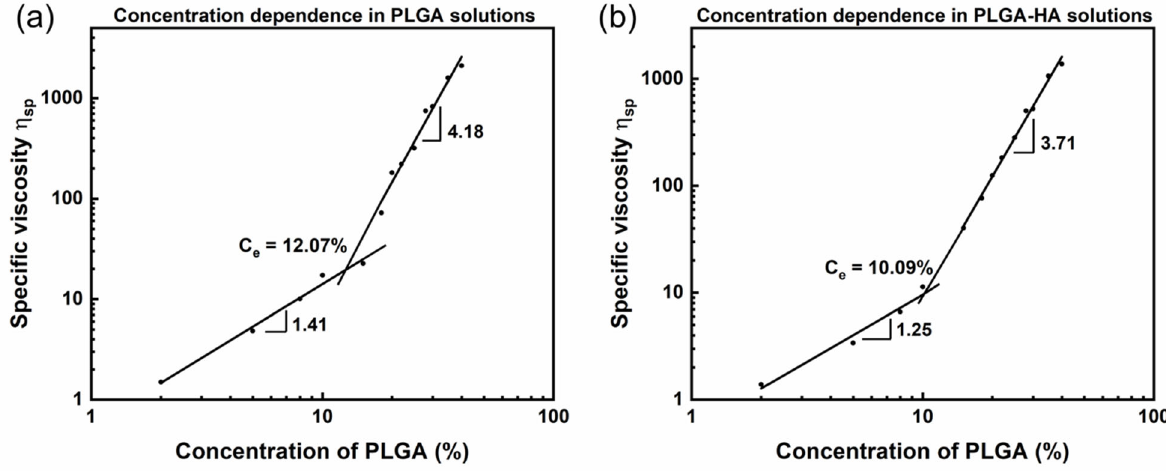
Figure 3. Dependence of specific viscosity on PLGA concentration for ( a ) PLGA in DMSO solutions, and ( b ) PLGA ‐ 1.5% HA in DMSO solutions. and ( b ) PLGA-1.5% HA in DMSO